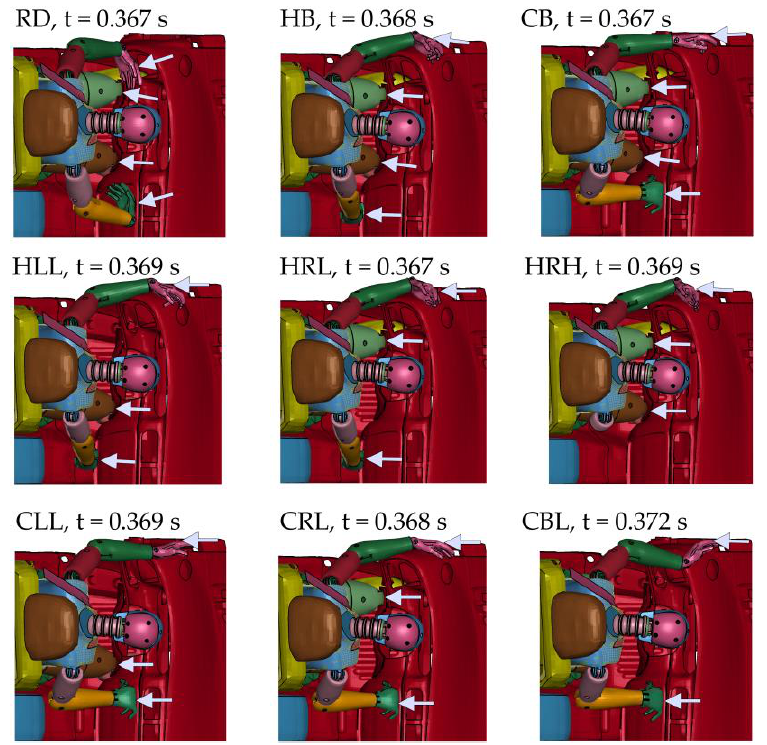
Figure 7. Positions of the dummy at the moments corresponding to the maximum longitudinal displacement.